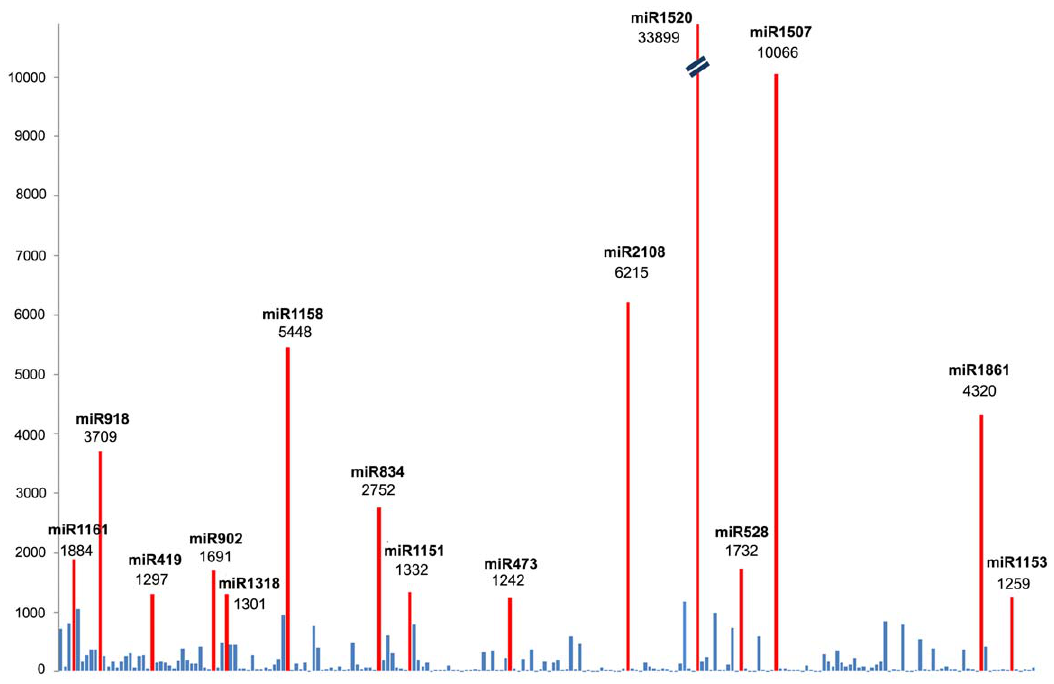
Figure 2. Frequency of known miRNAs in P.yezoensis .